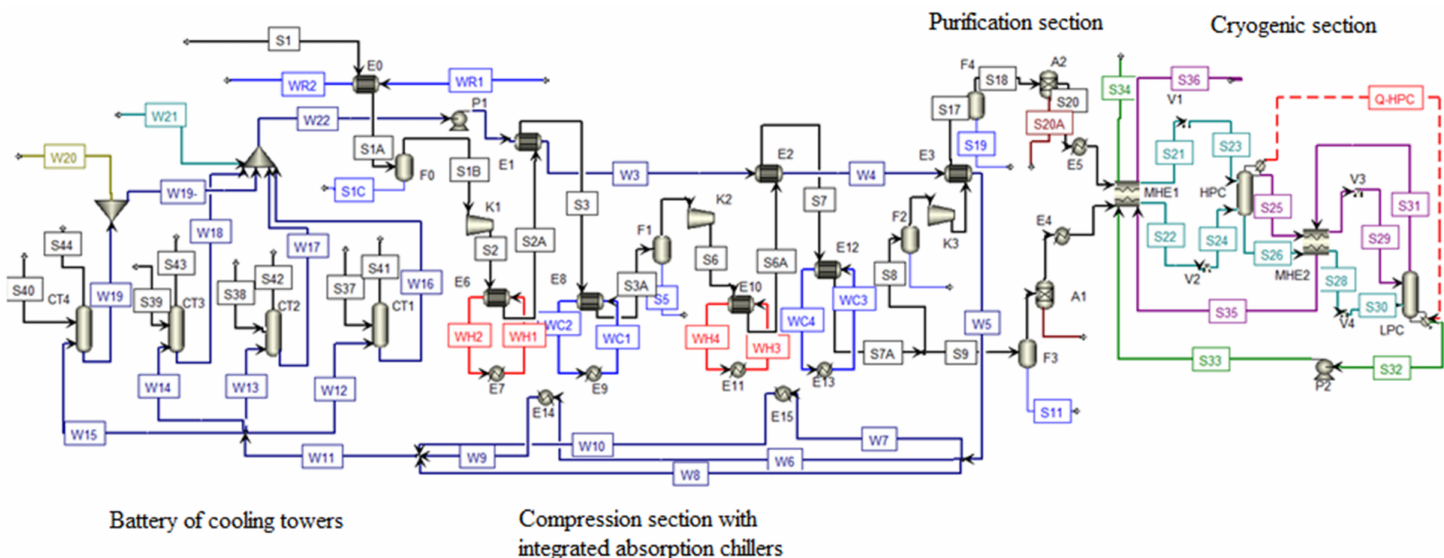
Figure 3. Process flow diagram of mathematical model comprising air pre-cooling and intercooling by absorption cooling equipment. WC: chilled water, WH: hot water, WR: return